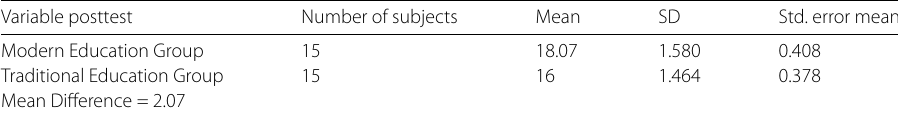
Table 3 Descriptive statistics of post-test in terms of groups Variable